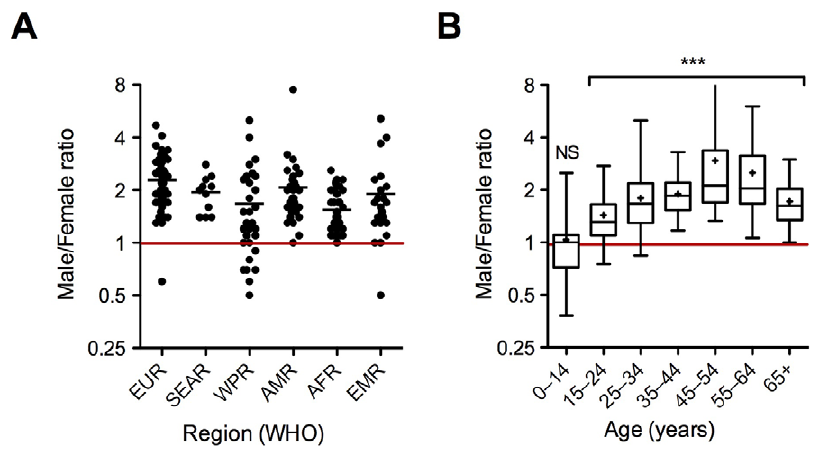
Figure 2. Regional (A) and age (B) distribution of the male/female ratio for new smear- positive TB cases in 2007. (A) Dot-plot in which each dot corresponds to a country. EUR, Europe; SEAR, Southeast Asia; WPR, Western Pacific; AMR, the Americas; AFR, Africa. The bar indicates the mean. (B) Box plot showing the 25th and 75th percentiles, together with the median, with whiskers showing the minimum and maximum male/female ratio for new smear- positive TB cases in 2007 in the Americas. Crosses indicate means. Data were compared with the male/female ratio expected under the hypothesis of neutrality (1, red line) and were analyzed with Mann-Whitney tests (***, p , 0.0001) [1]. NS, not significant.